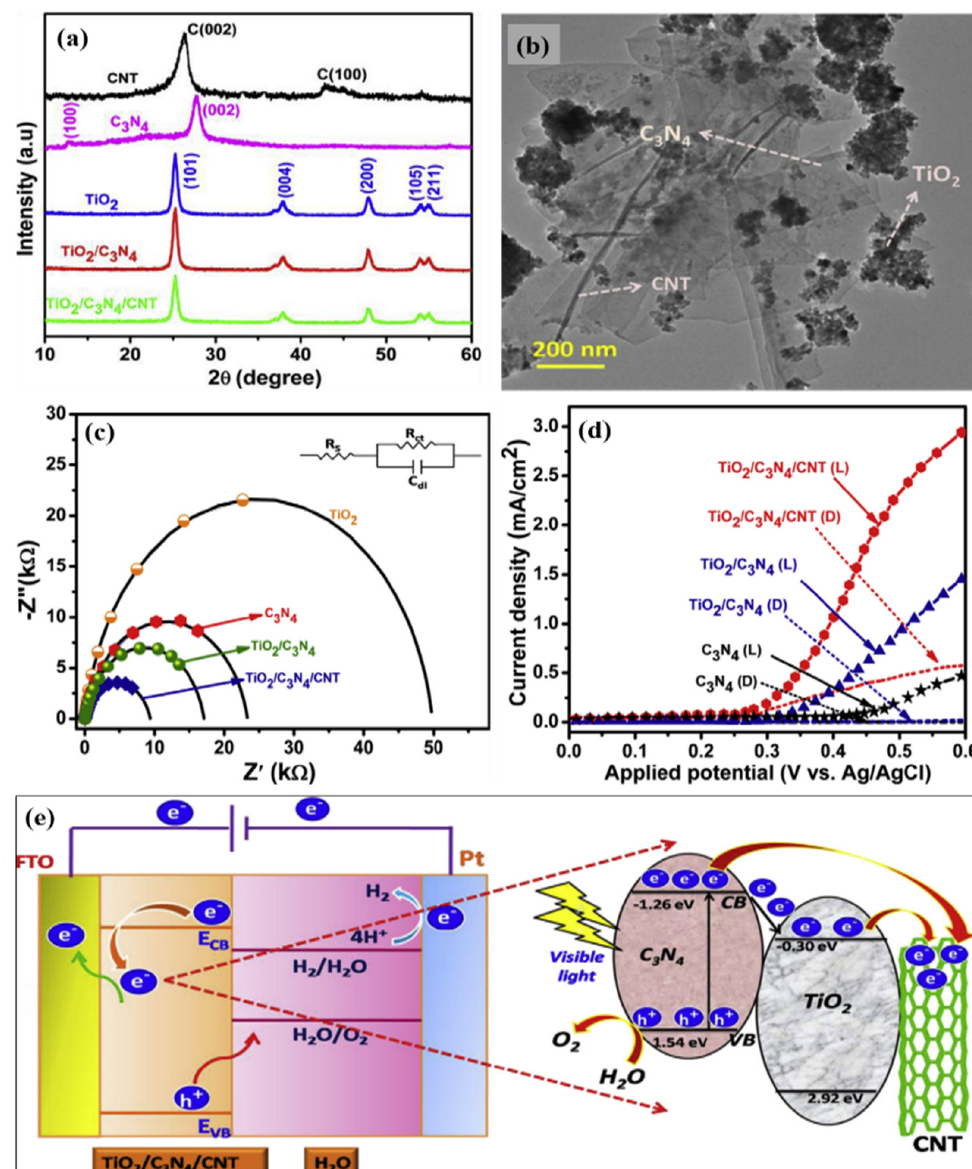
Figure 8. ( a ) XRD patterns, ( b ) TEM image of TO/CN/CNT heterostructured material, ( c ) Nyquist plots, ( d ) LSV curves, and ( e ) charge transfer mechanism of the TO/CN/CNT ternary heterostruc- tured electrode. Reprinted with permission from reference [98], Copyright 2020,